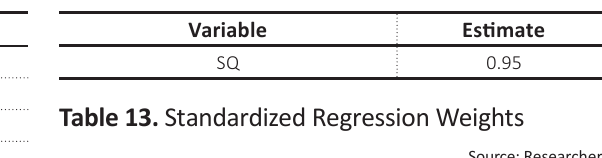
Table 12. Squared multiple correlations Source: Researchers.